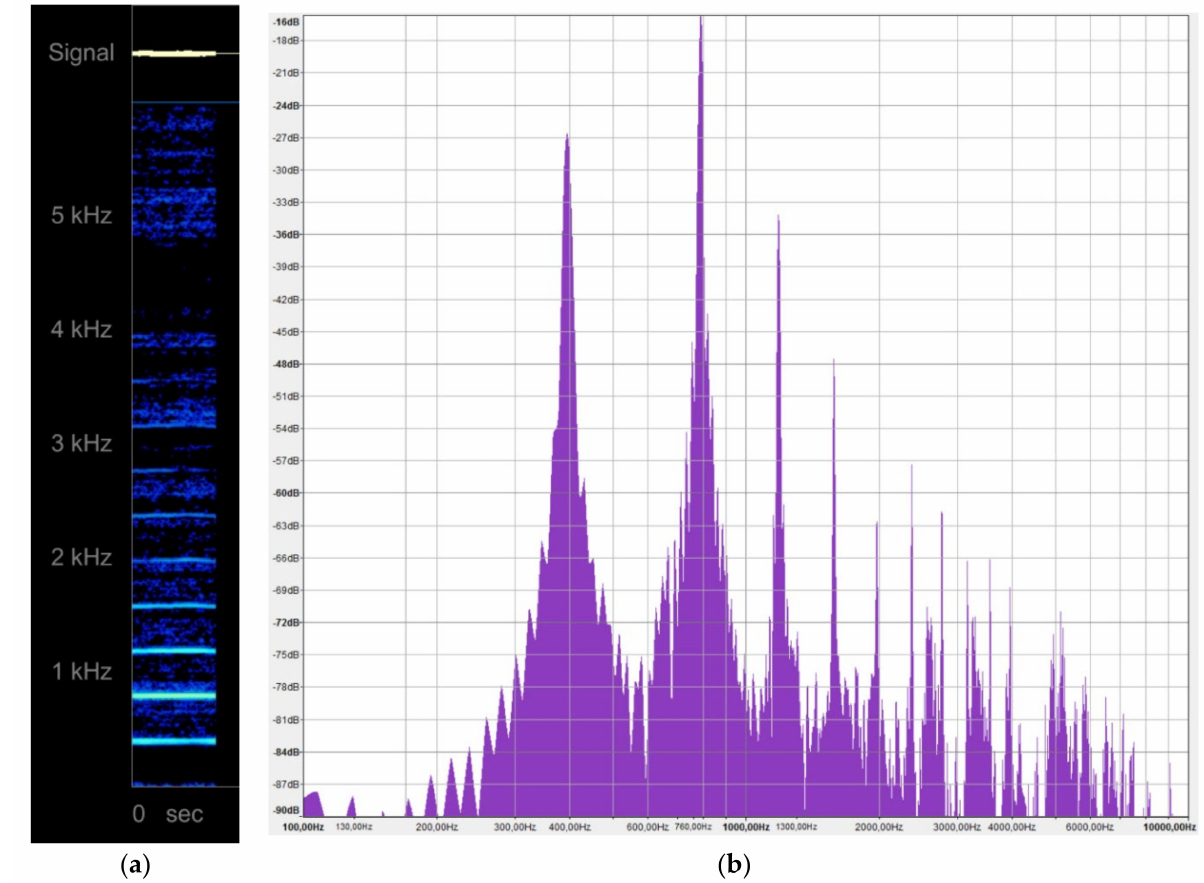
Figure 18. Spectral components of ceramic trumpet, experimental model, low blowing pressure, hand stopped: ( a ) spectrogram; ( b ) spectrum (Sample